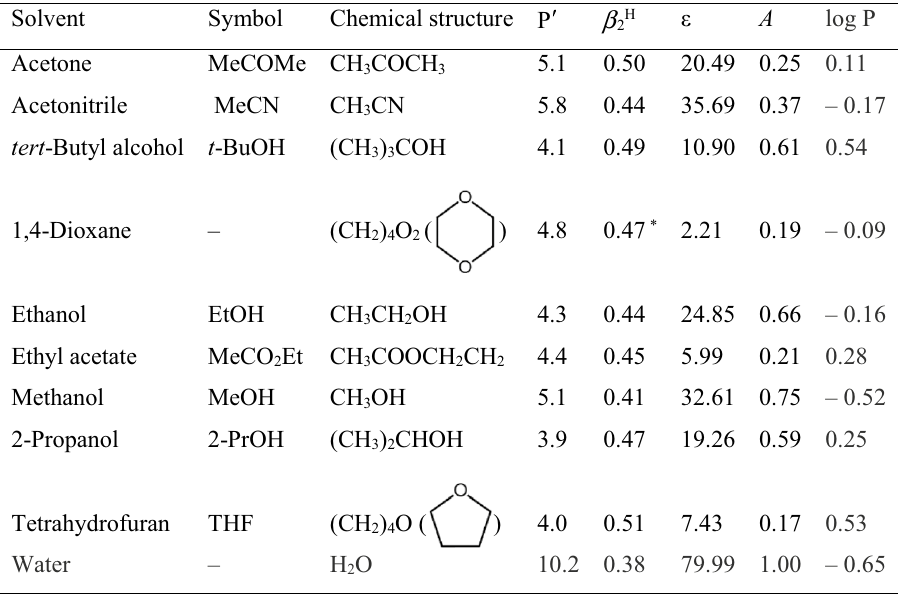
Table 1. Selected reaction solvents in DPPH · assay plus some of their physicochemical properties. P ′ : Polarity index 23 ; β 2 H : Relative hydrogen bond accepting (HBA) ability 24 ; ε: Dielectric constant 25 ; A : Anion solvating abilities of solvents 26 ; log P: Octanol/water partition coefficient 27 ; *28